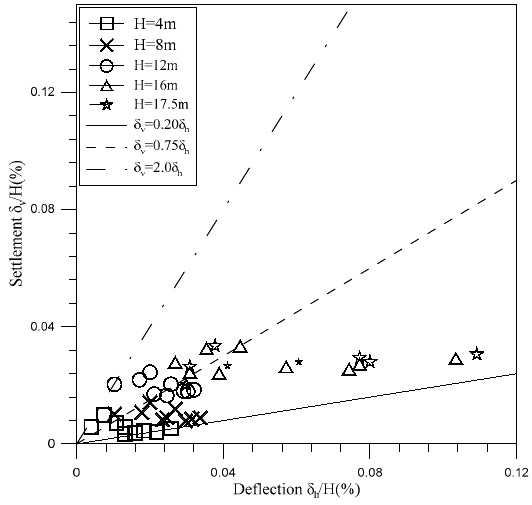
Figure 22. Deflection and settlement of the retaining wall (nodes 23–31).